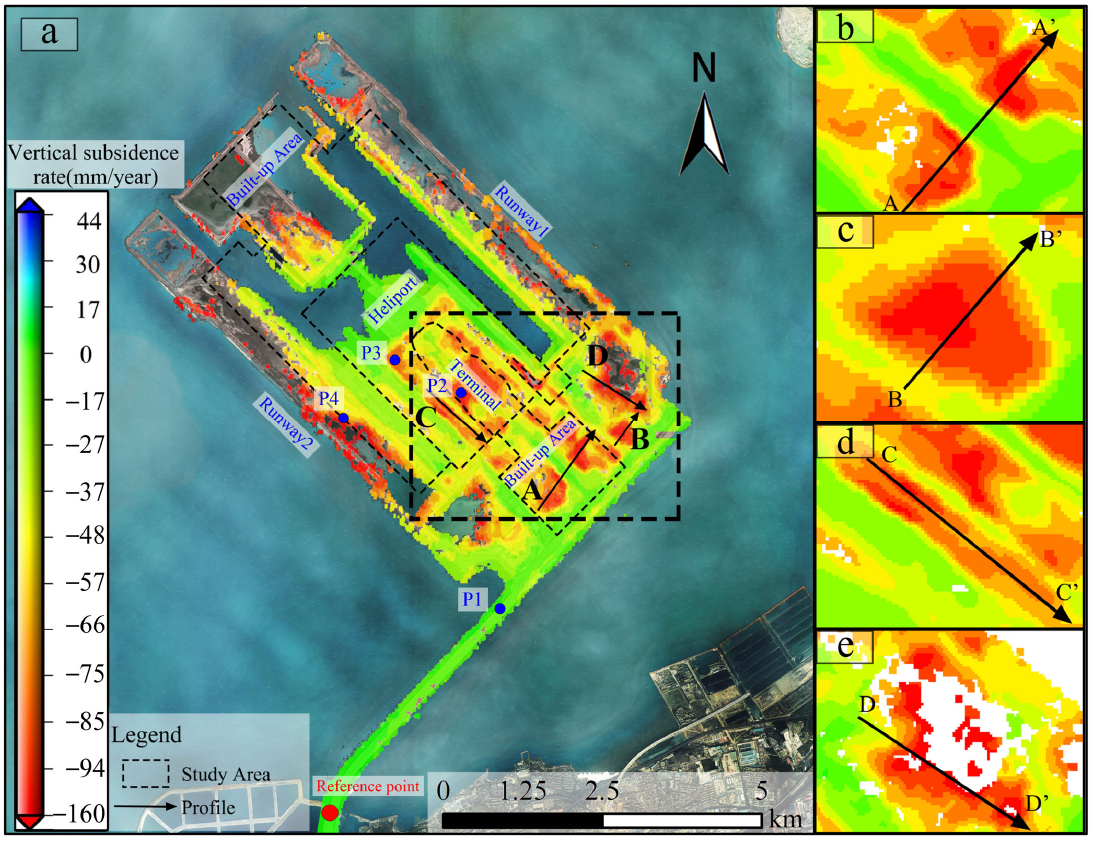
Figure 6. ( a ) Average annual vertical subsidence rate of Jinzhou Bay International Airport; ( b – e ) Subsidence rate along profiles AA′, BB′, CC′, and DD′, respectively; The blue points P1, P2, P3, and P4 in ( a ) were shown in Figure 8 with their accumulated subsidence; The red point in ( a ) denotes the reference point.